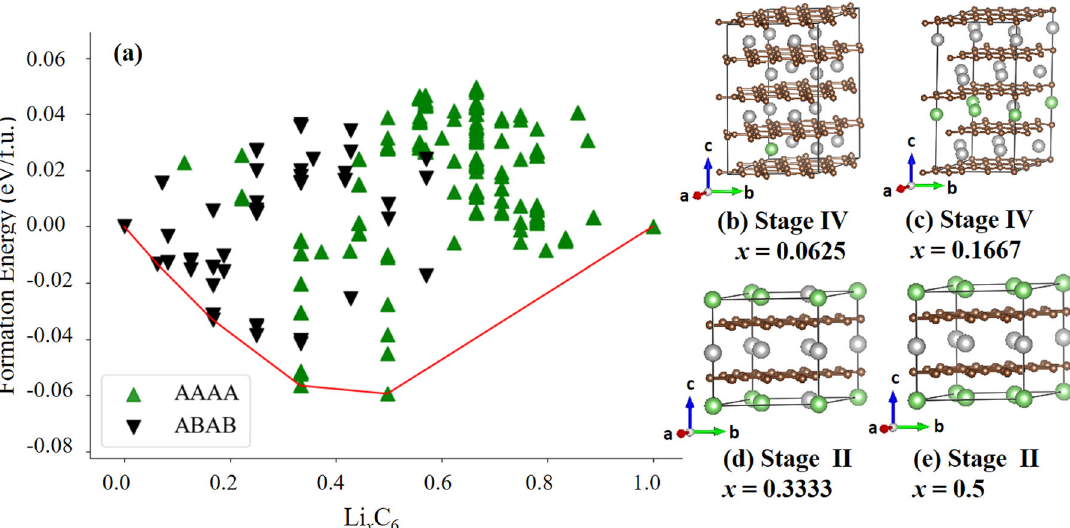
Fig. 4 Convex hull of Li x C 6 (0 < x < 1). a Formation energies (per formula unit, Δ E f ) of Li x C 6 as a function of Li composition. Ordered ground states determined by the convex hull at x = b 0.0625, c 0.1667, d 0.3333, e 0.5. Energies larger than 50 meV are discarded.